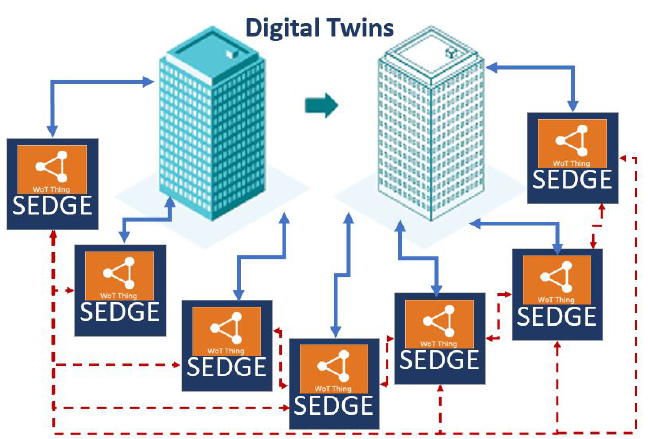
Figure 10. WoT to digital twin architecture.